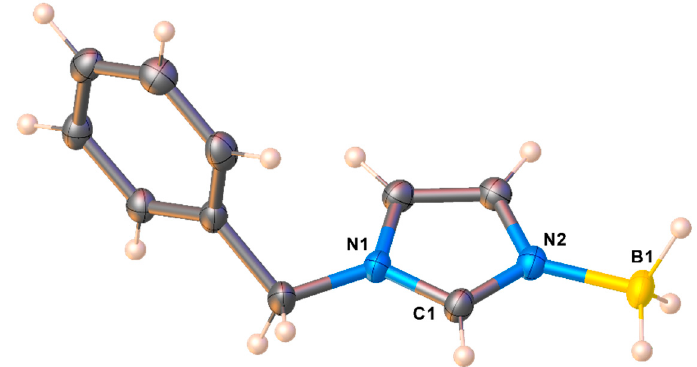
Figure 1. Molecular structure of (HIm Bn )BH 3 ( 1 ). Selected bond distances (Å) and angles ( ˚ ): N1-C1 1.343(2), N2-C1 1.323(2), N2-B1 1.587(2), N1-C4 1.474(2), N1-C1-N2 110.29(14), C1-N2-B1 126.58(14).